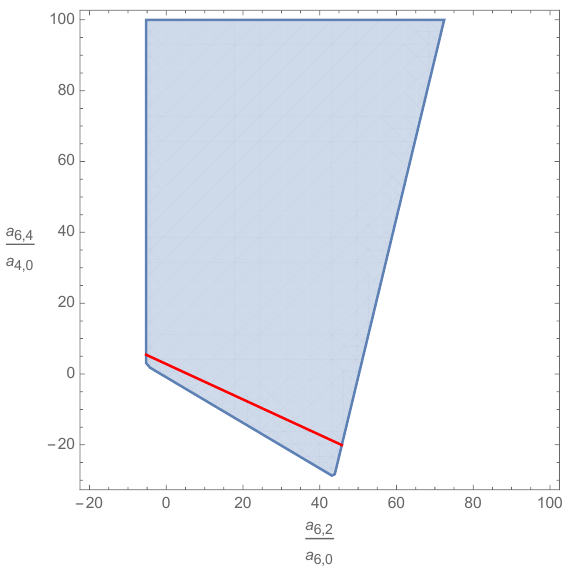
) . The shaded region is carved out by the unitary Figure 13 . The space of allowed ( a 6 , 2 , a 6 , 4 a 6 , 0 a 6 , 0 polygon, whose boundary is comprised of ( ‘, ‘ + 2) with ‘ ≥ 2 , and (2 , ∞ ) . Note that spin-0 is inside the hull and thus not part of the boundary. Finally the red-line represents in the intersection of the permutation “line” X , and the unitary perm